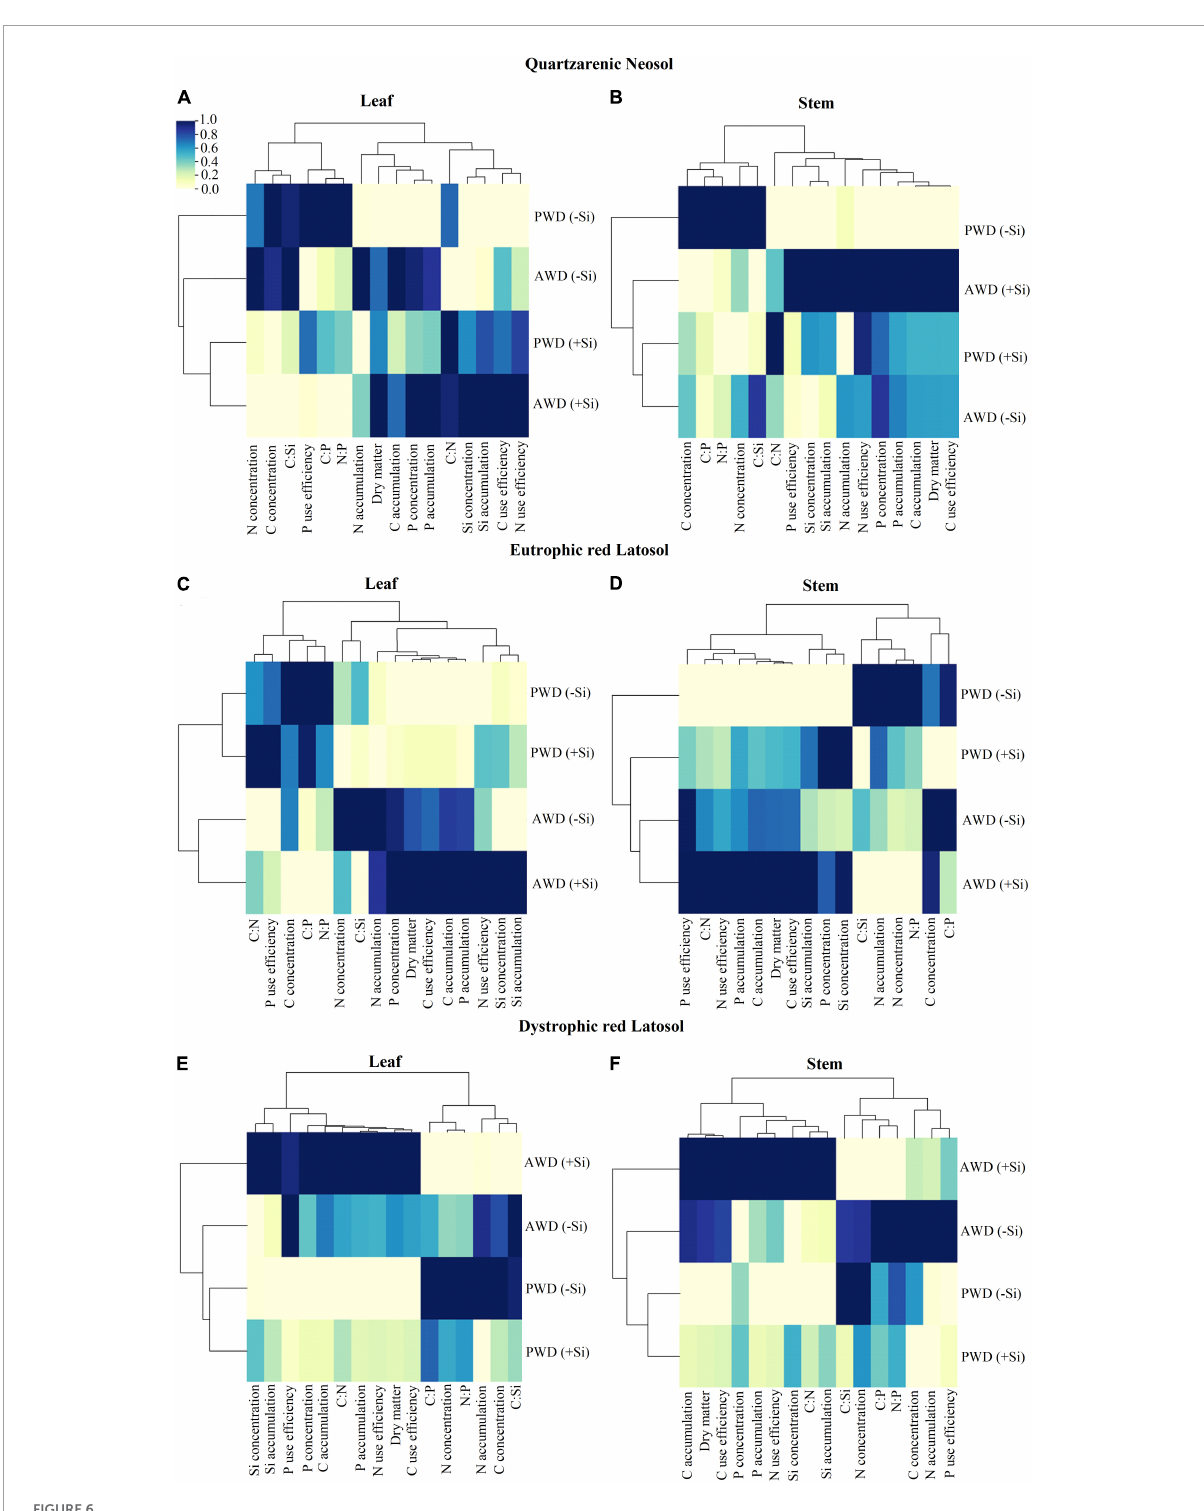
FIGURE6 Heat map of hierarchical clustering of variables of concentrations and accumulations of C, N, P, and Si, stoichiometric ratios of C:N:P:Si, use efficiencies of C, N, and P, and dry mass partition in the leaf (A,C,E) and in the stem (B,D,F) of sugarcane cultivated with absence (0.0 mM) and presence of fertigated Si (1.8 mM) and two water conditions (without—AWD and with water deficit—PWD) in three tropical soils (Quartzarenic Neosol; Eutroferric Red Latosol; and Dystrophic Red